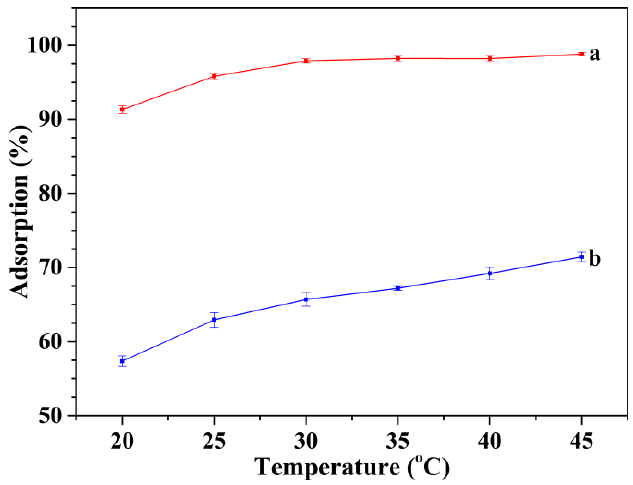
Figure 6. Effect of temperature on Pb 2+ adsorption of the Alg-Mel. (~100 mg ( a ) and ~20 mg ( b ) of Alg- Mel was equilibrated with 40 mL of 0.48 mM Pb 2+ at 25 °C and pH 5.0 for 6 h, respectively).